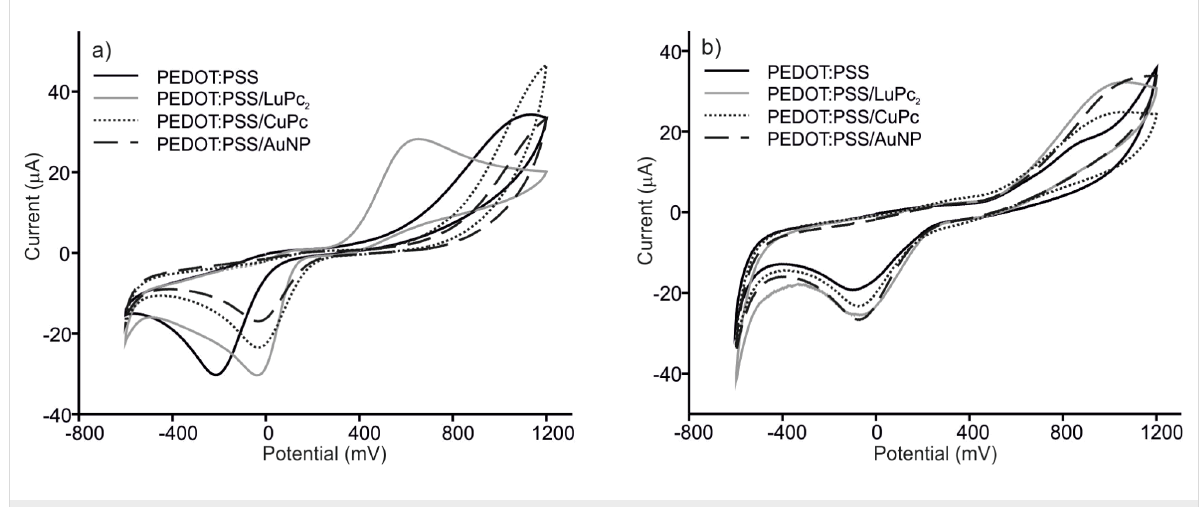
Figure 2: Cyclic voltammograms of PEDOT/PSS, PEDOT/PSS/LuPc 2 , PEDOT/PSS/CoPc and PEDOT/PSS/AuNP sensors in (a) catechol and (b) hydroquinone 1.5 × 10 − 4 mol·L − 1 with 0.01 mol·L − 1 phosphate buffer as the supporting electrolyte. Scan rate 0.1 V·s − 1 .